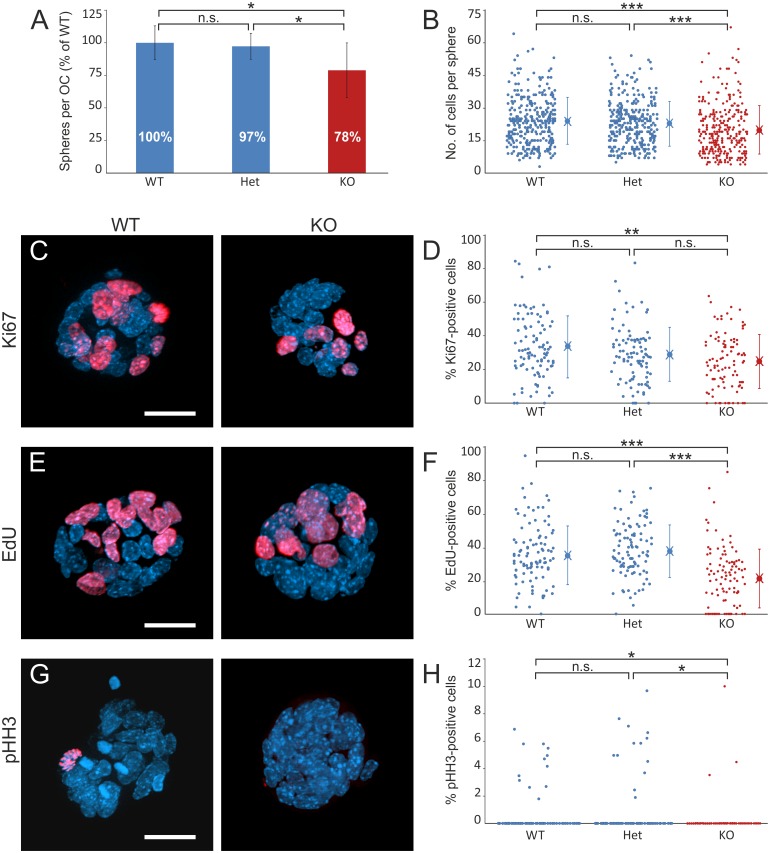
Sphere-forming capacity of the neonatal Bmi1 knockout organ of Corti.(A) Average number of spheres per OC, expressed as a percentage of the WT control (mean ± standard deviation). The data represent the results from a total of 9 WT, 19 Het and 6 KO p0 mice pooled from 4 independent experiments. Cultures from the KO mice generated significantly fewer spheres compared to their WT littermates (one-way ANOVA followed by Tukey‘s post-hoc test, p<0.05). The difference between the WT and Het mice is not significant. (B, D, F and H) Quantification of DAPI, Ki67, EdU and pHH3. Each data point represents one sphere. Mean and standard deviation values are shown in the dot plots. (B) Number of DAPI-labeled cells per sphere. The number of cells per sphere is significantly reduced for the Bmi1 KO spheres compared to the WT spheres (p<0.001, Dwass-Steel test; n = 300 spheres per group). The difference between WT and Het mice is not statistically significant. (C, E and G) Representative images of the WT and KO spheres, labeled for Ki67 (C), EdU (E) and pHH3 (G). (D) Percentage of Ki67-positive cells in the spheres: the KO spheres harbor a significantly lower percentage of Ki67-positive cells compared with the WT spheres (p<0.01, Dwass-Steel; n = 100 spheres per group). There was no significant difference between the WT and Het mice, or between Het and KO mice. (F) Percentage of EdU-incorporating cells in the spheres: the KO spheres contain a significantly lower percentage of EdU-positive cells compared with the WT spheres and Het spheres (p<0.001, Dwass-Steel test; n = 100 spheres per group). The difference between the WT and Het mice is not significant. (H) Percentage of pHH3-positive cells in the spheres: the percentage of pHH3-expressing cells is significantly lower in the KO spheres compared with the WT spheres (p<0.05, Dwass-Steel test; n = 100 spheres per group). There was no statistically significant difference between the WT and Het spheres. WT: wildtype, Het: heterozygous, KO: knockout. *p<0.05, **p<0.01, ***p<0.001.